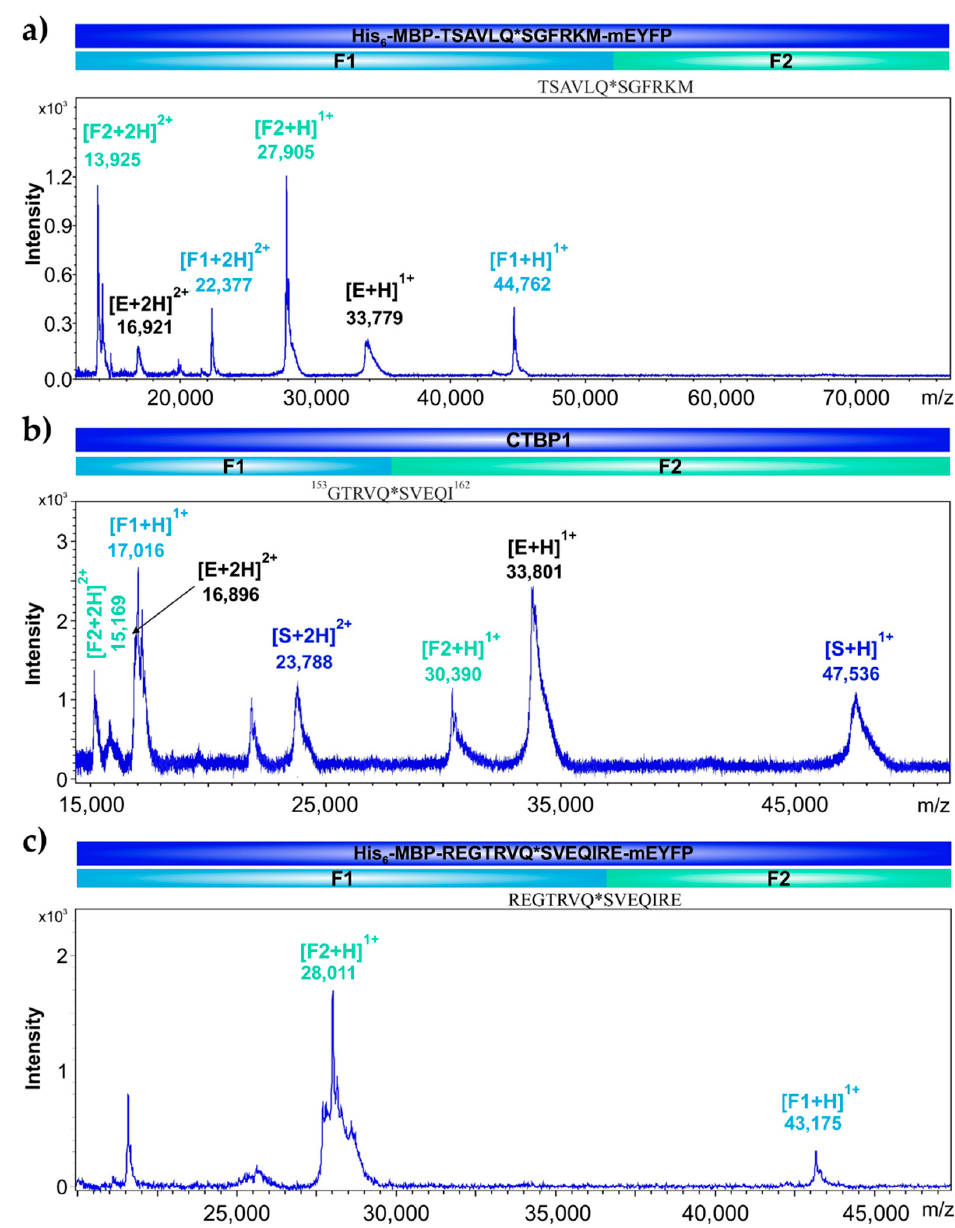
Figure 9. Determination of cleavage sites by MALDI-TOF MS. In cleavage reactions His 6 -MBP-TSAVLQ*SGFRKM-mEYFP ( a ), recombinant CTBP1 ( b ), and His 6 -MBP-REGTRVQ*SVEQIRE-mEYFP proteins ( c ) were used as substrates. Molecular weights (Da) of SARS-CoV-2 3CLpro are labeled by black, values for the full-length substrates are shown by dark blue color, while the proteolytic fragments are colored by light blue and green, respectively. Cleavage site sequences are also shown, asterisks indicate cleavage position. Table 2. Kinetic parameters determined for SARS-CoV-2 3CLpro using His 6